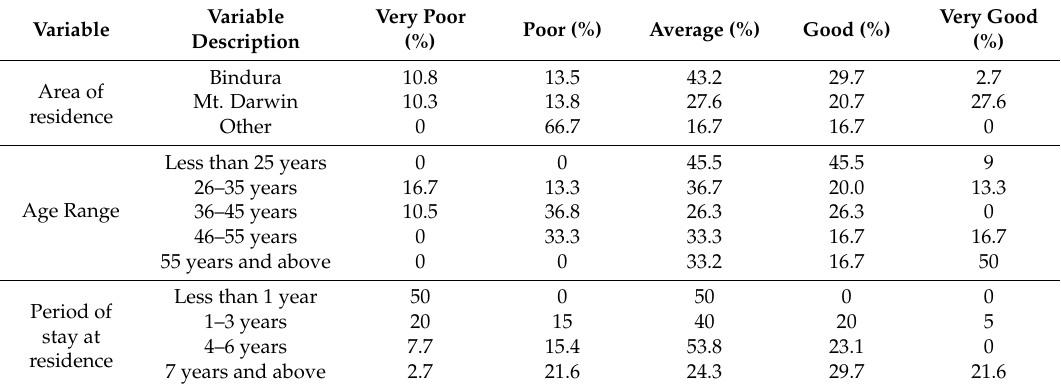
Table 5. The public’s perception of the Z.R.P’s service delivery, N = 73.